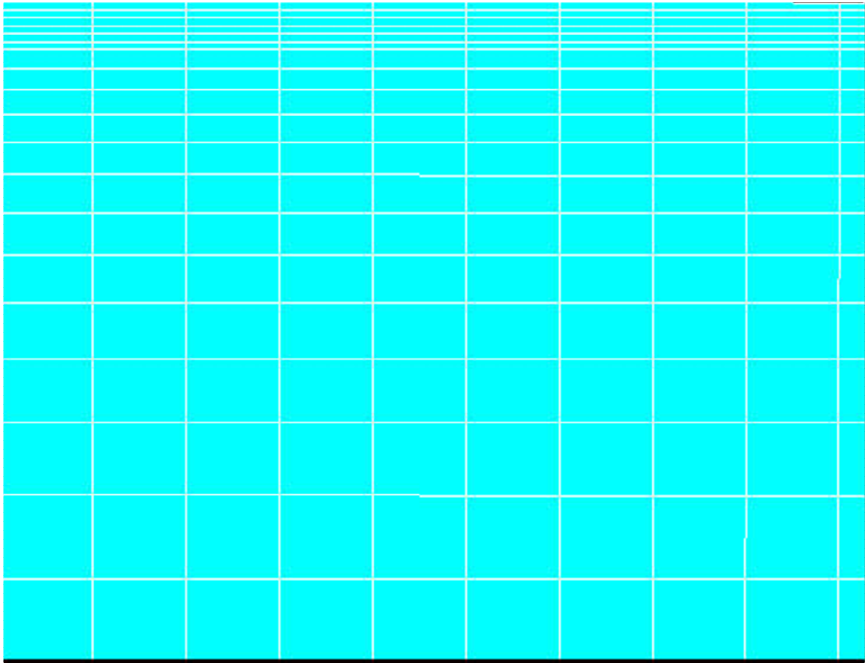
Figure 5. A fragment of the mesh used for the FEA (portions of the upper face skin and honeycomb are shown). The face skin has 6 divisions radially (the upper six “layers” of elements in the Figure). The honeycomb core has 32 divisions radially.